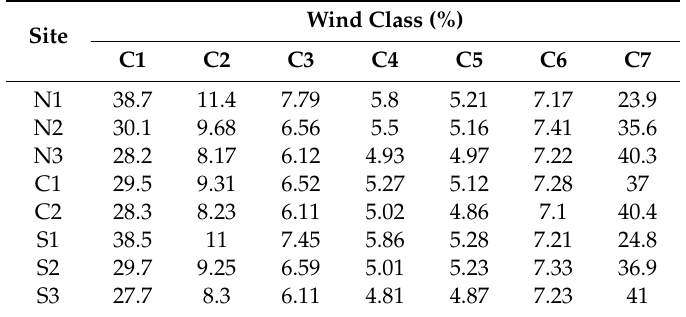
Table 3. Percentage of wind classes for the U 100 parameter, corresponding to the 20-year time interval of 2000–2019. Wind Class (%) Site C1 C2